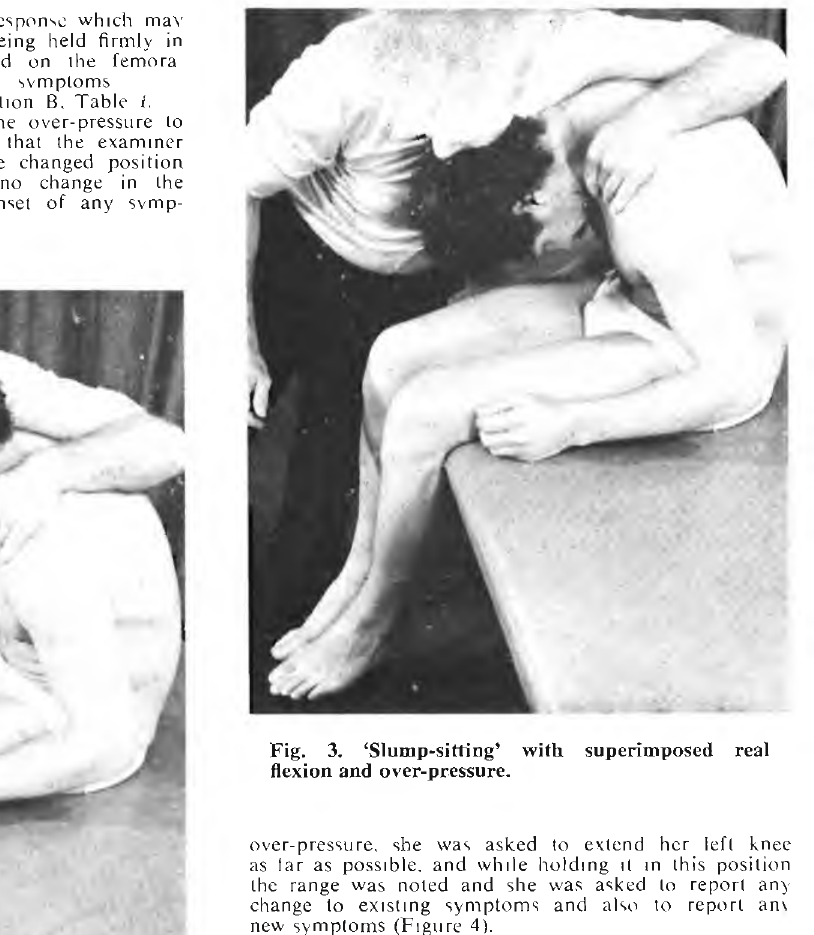
Fig. 3. ‘Slump-sitting’ with superimposed real flexion and